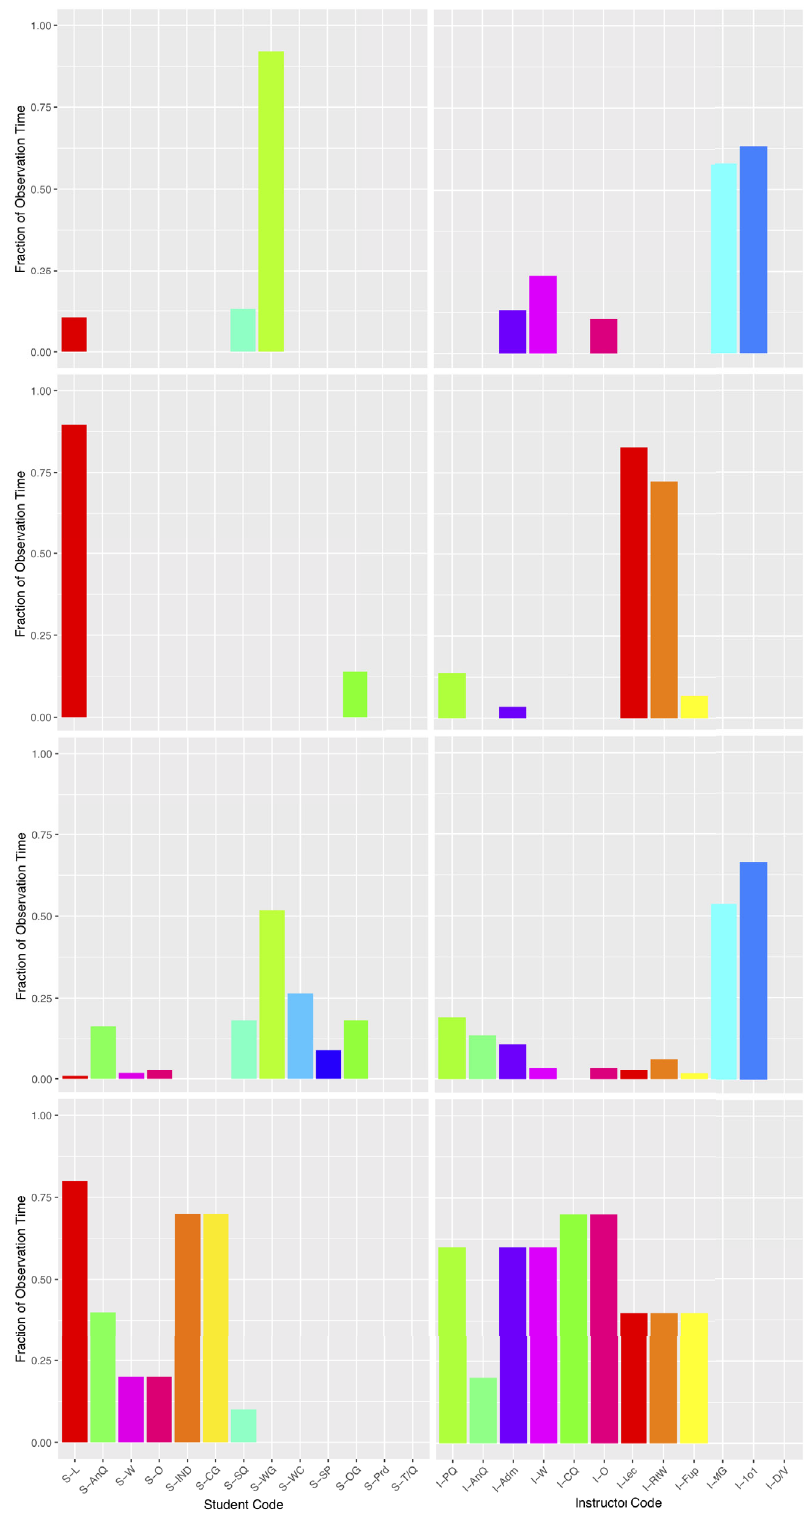
FIG. 4. Top row: ISLE, whole class implementation, recitation section. Second row: ISLE, whole class implementation, lecture section. Third row: Modeling Instruction. Last row: Peer